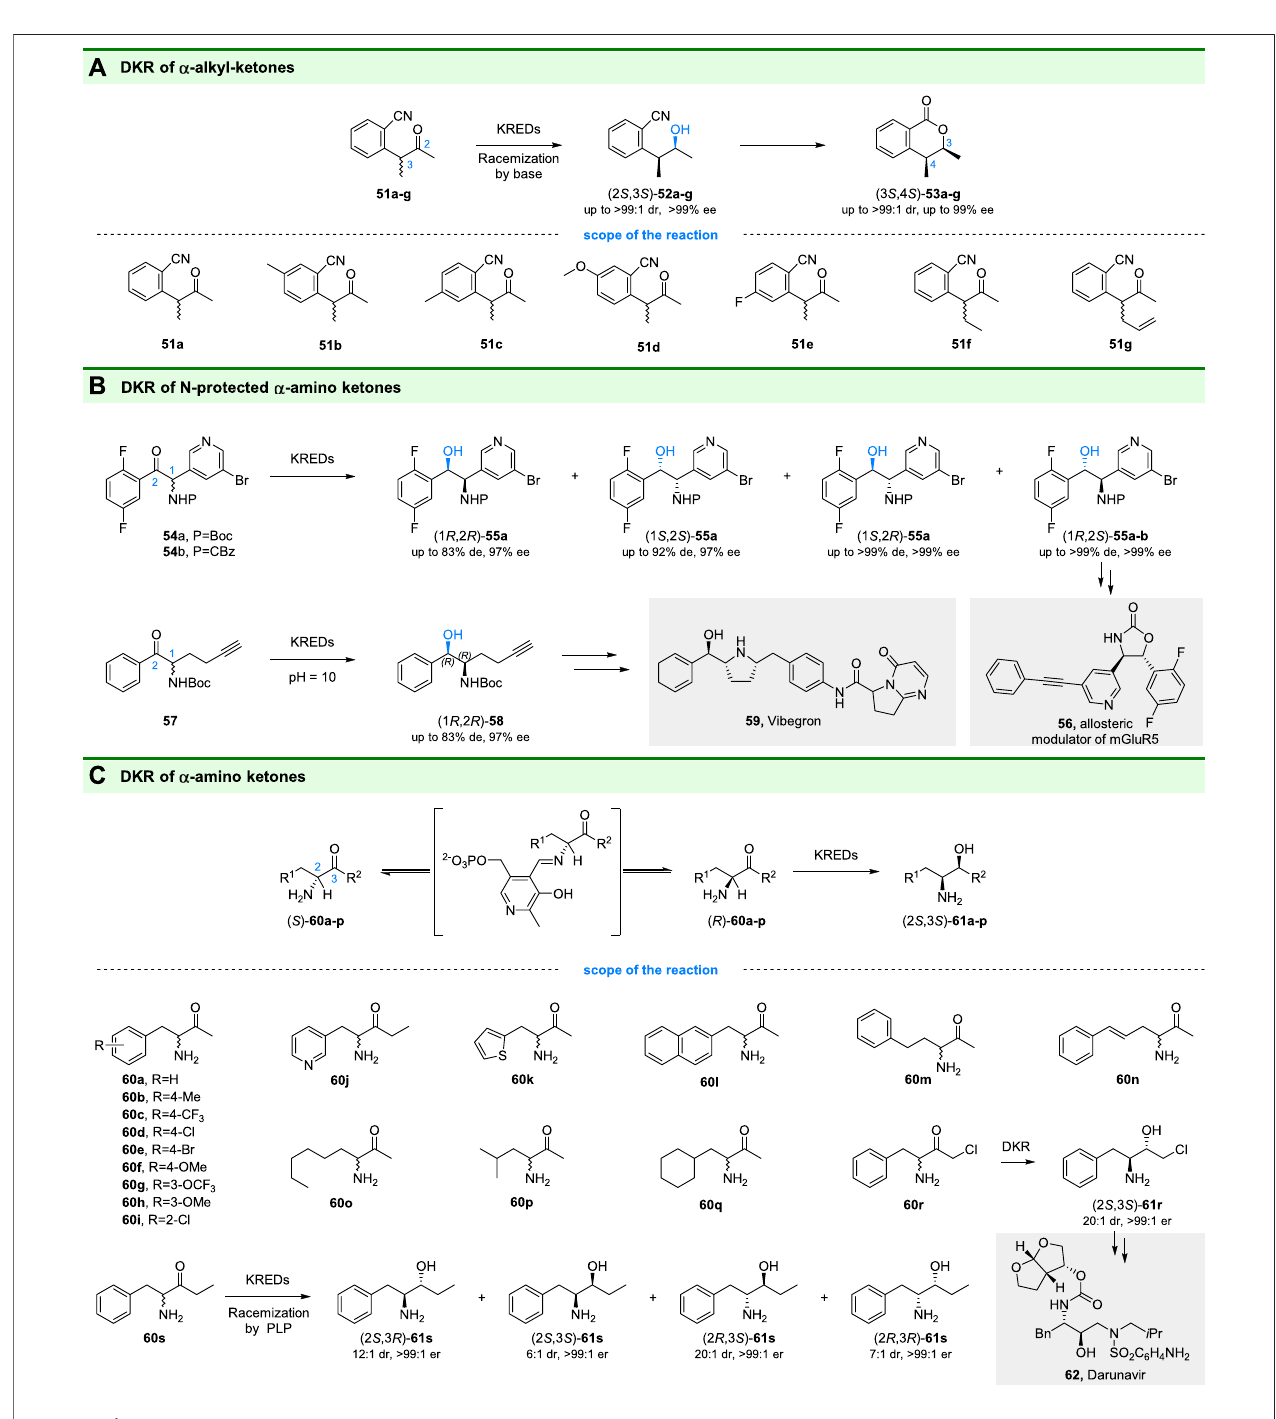
FIGURE 9 | DKR of α -substituted ketones. (A) DKR of α -alkyl ketones, (B) DKR of N-protected α -amido ketones, and (C) DKR of α -amido ketones.